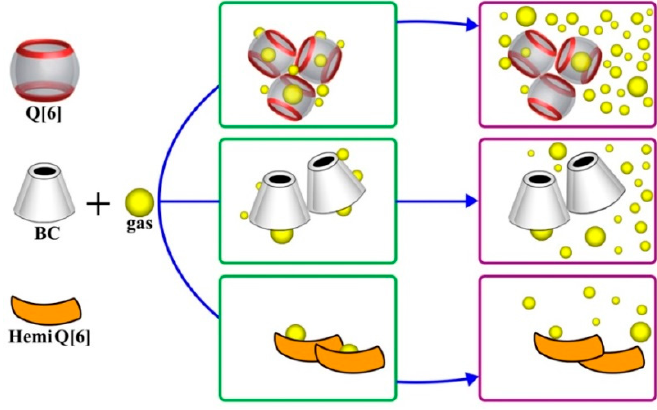
Figure 8. Schematic diagram of heterogeneous nucleation of Q[6], HQ[6], and BC.